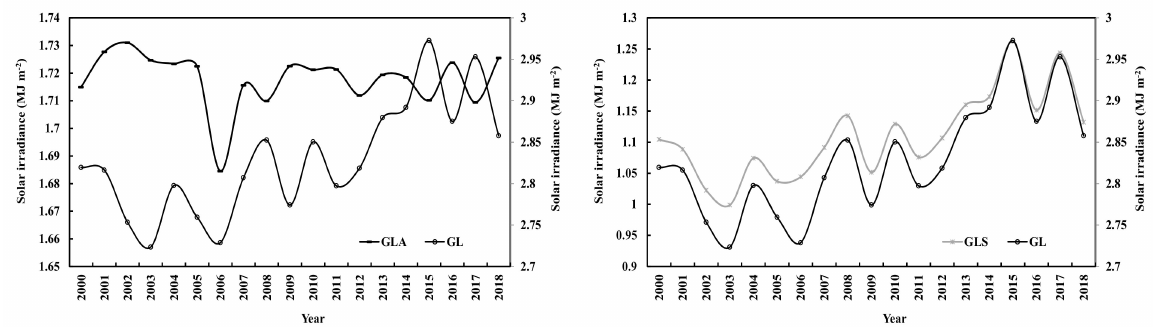
Figure 12. Annual losses of global solar irradiance caused by absorbing and scattering substances and total loss during April–September. G L uses the right y -axis in the 2